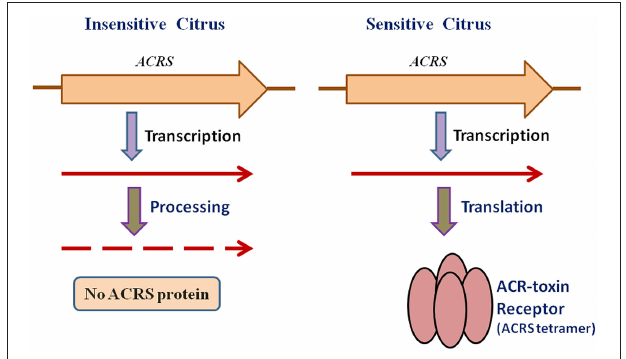
FIGURE 3 | Mechanism of ACR-toxin sensitivity controlled by receptor transcript processing in